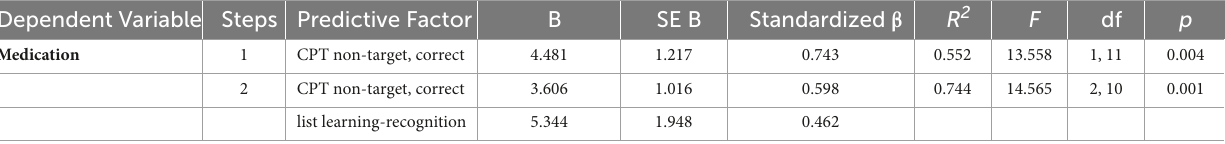
TABLE 2 Summary of the second set of stepwise regression analyses regarding neuropsychological tests with the greatest contribution to medication adherence, as assessed by the DAD ratings. Dependent Variable Steps Predictive